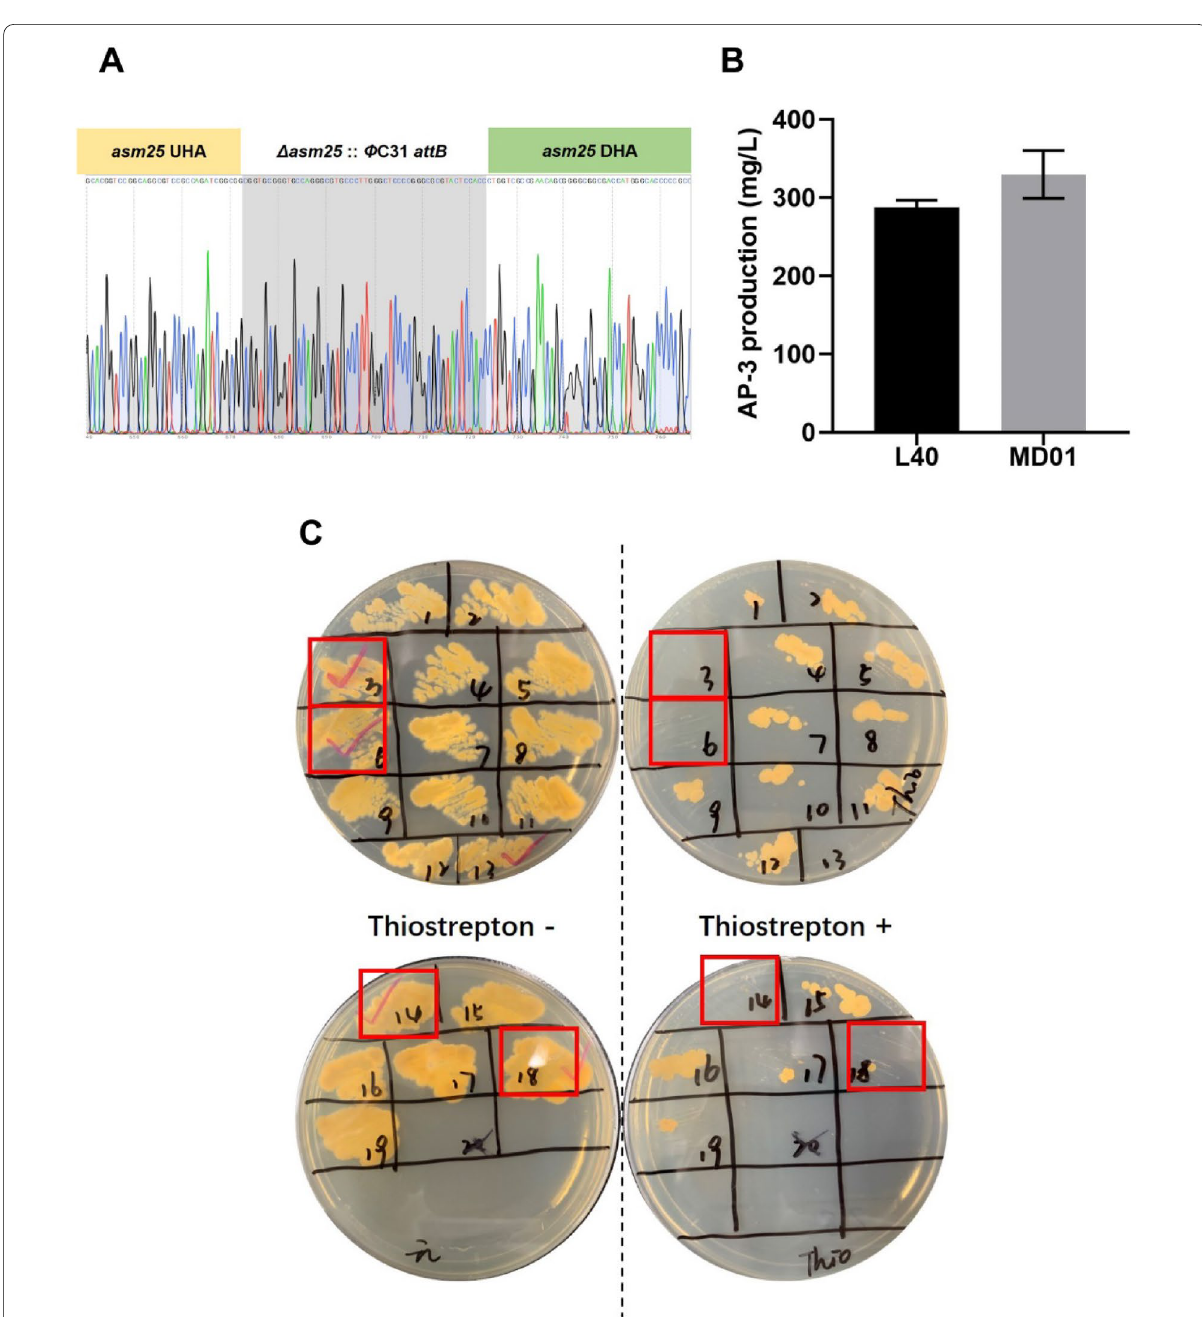
Fig. 3 CRISPR–Cas9 system mediated asm25 gene inactivation in A. pretiosum . A Sanger sequencing chromatograms for mutant MD01, the Φ C31 attB replaced asm25 gene sequence showing in grey. B Comparison of AP-3 production of mutant MD01 and parent strain L40. MD01, mutant with asm25 deletion. A roughly 14.5% increase in AP-3 production for MD01 compared to that of strain L40. C Marker-free mutant screening. Colonies were inoculated into YMG plate with thiostrepton and without antibiotics, respectively, to verify the curing of